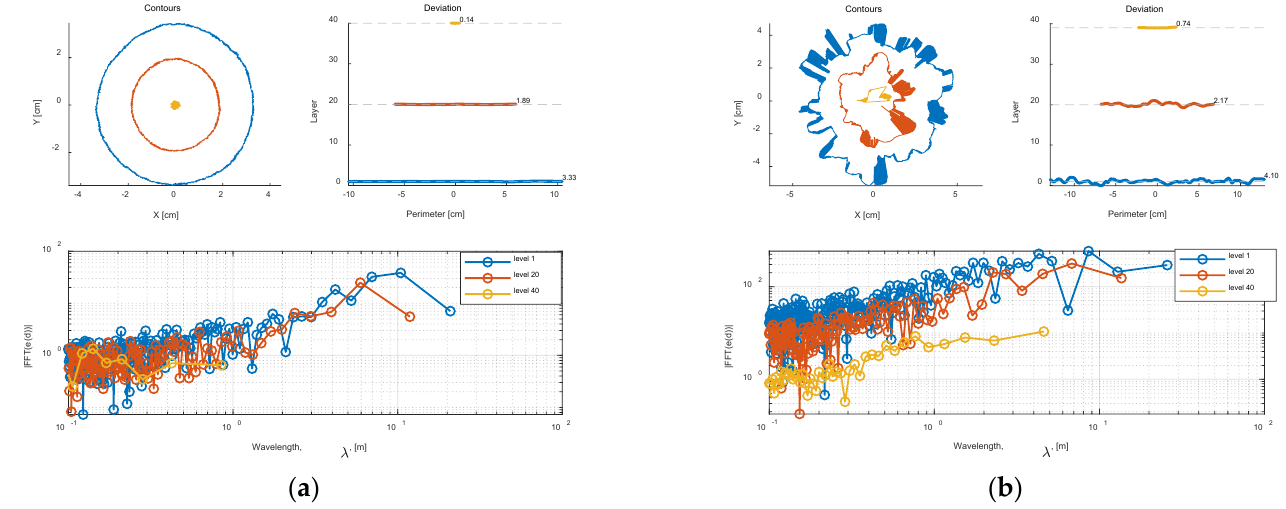
Figure 12. ( a ) The contours, deviations, and frequency response of a Class 0 sample; ( b ) the contours, deviations, and frequency response of a Class 3 sample.